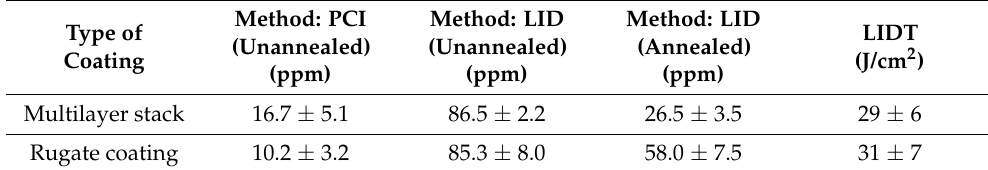
Table 6. Absorption measurements for AR coatings at 355 nm